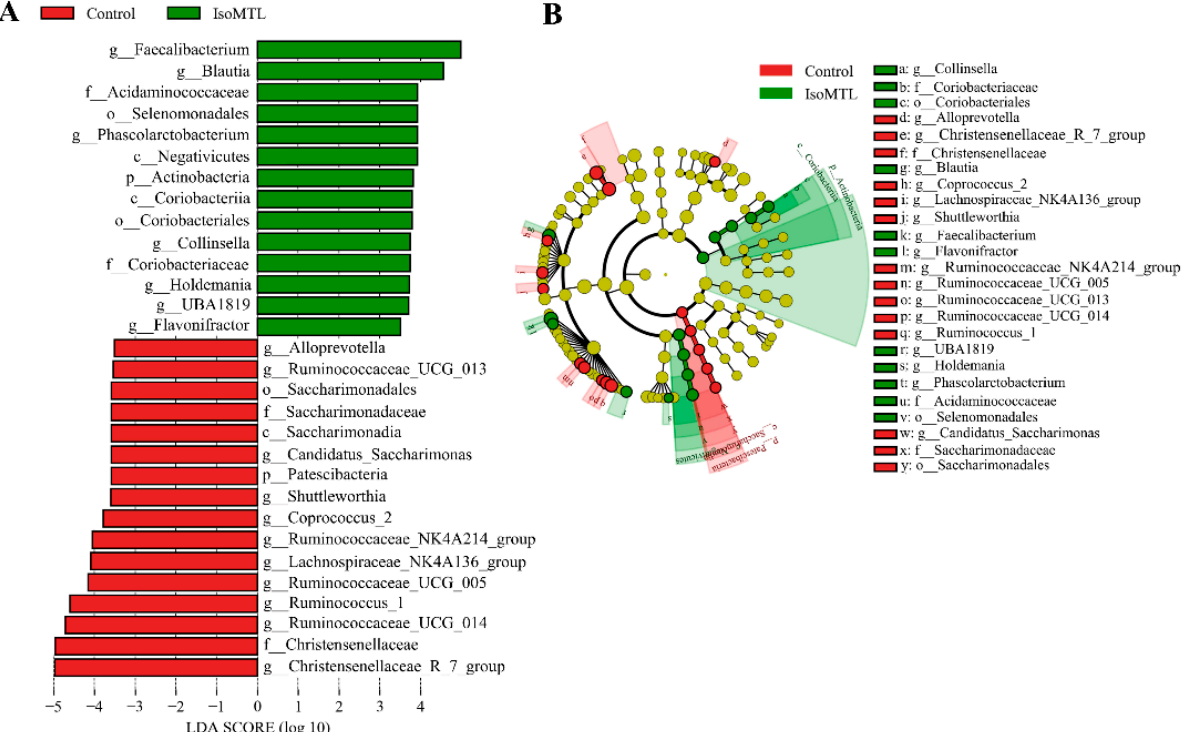
Figure 4. The significant altered microbiota at different taxonomic levels. ( A ) Significantly different bacterial species with LDA score log 10 ≥ 3.5 and p < 0.05 from phylum to genus. ( B ) Taxonomic cladogram obtained through LEfSe profiling based on 16S rRNA sequencing data.